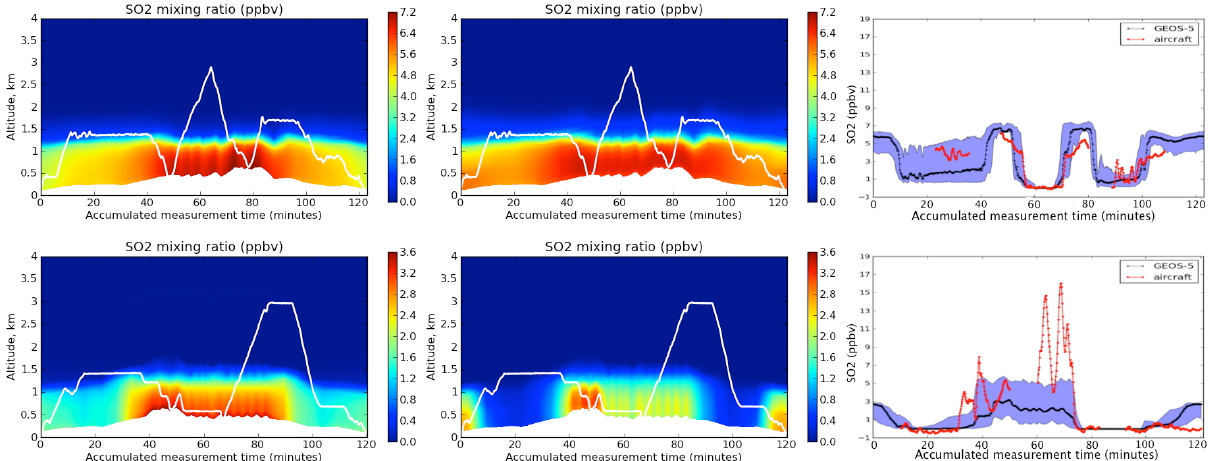
Fig. 12. GEOS-5/GOCART SO 2 simulations for the control run (left), the revised run (middle) along the flight track on 8 Novem- ber 2010 (top), on 9 November 2010 (bottom). Modeled SO 2 vertical profiles for the control run (left) and revised run (middle), the white line is the aircraft altitude, on the right, the red line is the observed SO 2 concentration, the black line is the modeled SO 2 concentration (revised run), and the blue shading shows the range of simulated SO 2 for the surrounded